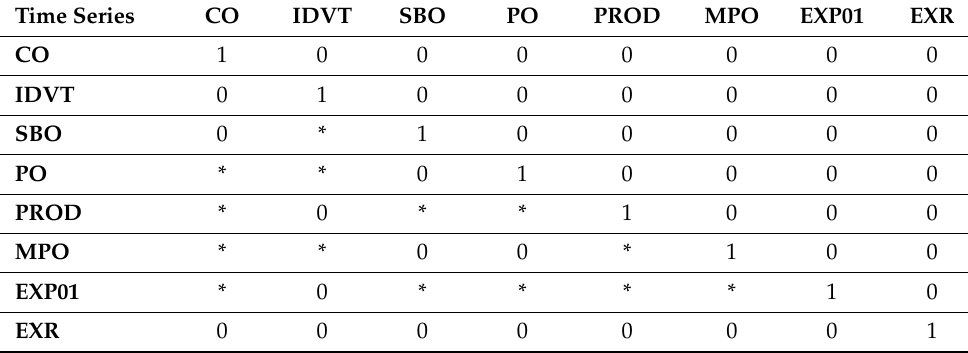
Table 4. The restrictions based on restrictions set by the author in Table